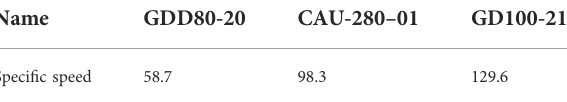
TABLE 8 Pump Speci fi c speed. Name